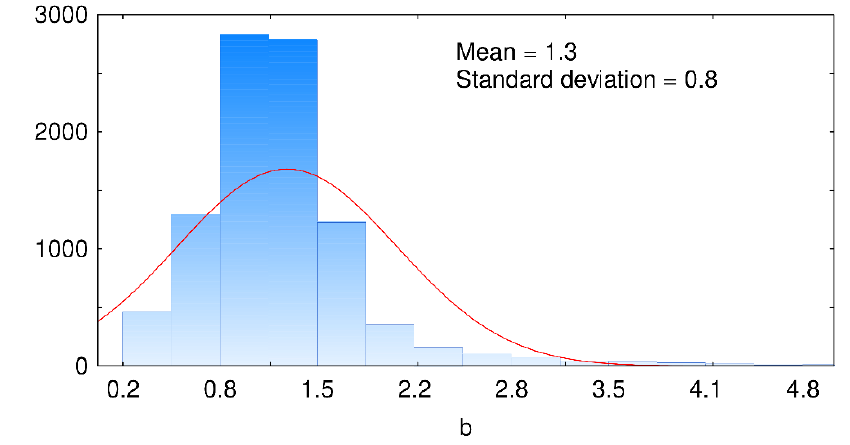
Figure 8. Distribution of coefficient b.